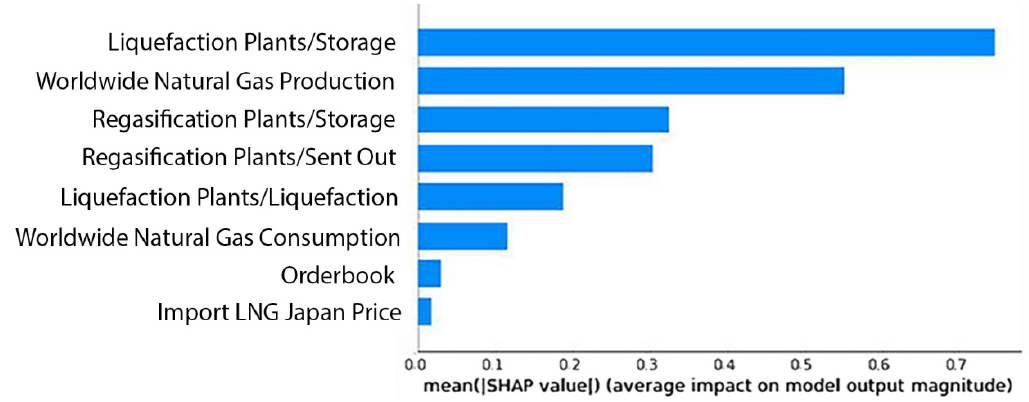
Figure 5. SHAP summary plot for LNG 145K CBM spot rate: 4 months of MLP model.